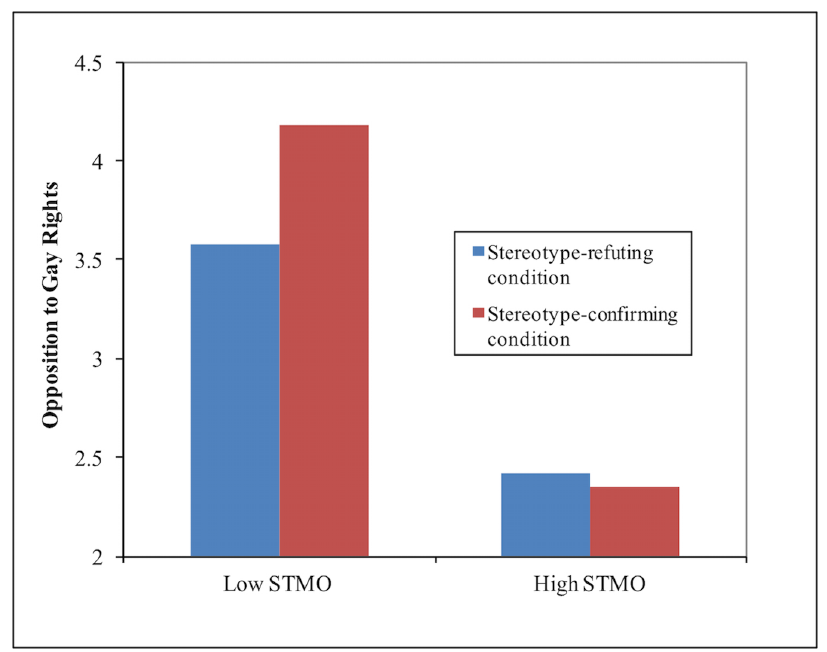
Fig 1. Effect of experimental condition (red vs. blue bars) on opposition to gay rights (y axis) at STMO scores one standard deviation below the mean (low STMO) and at STMO scores one standard deviation above the mean (high